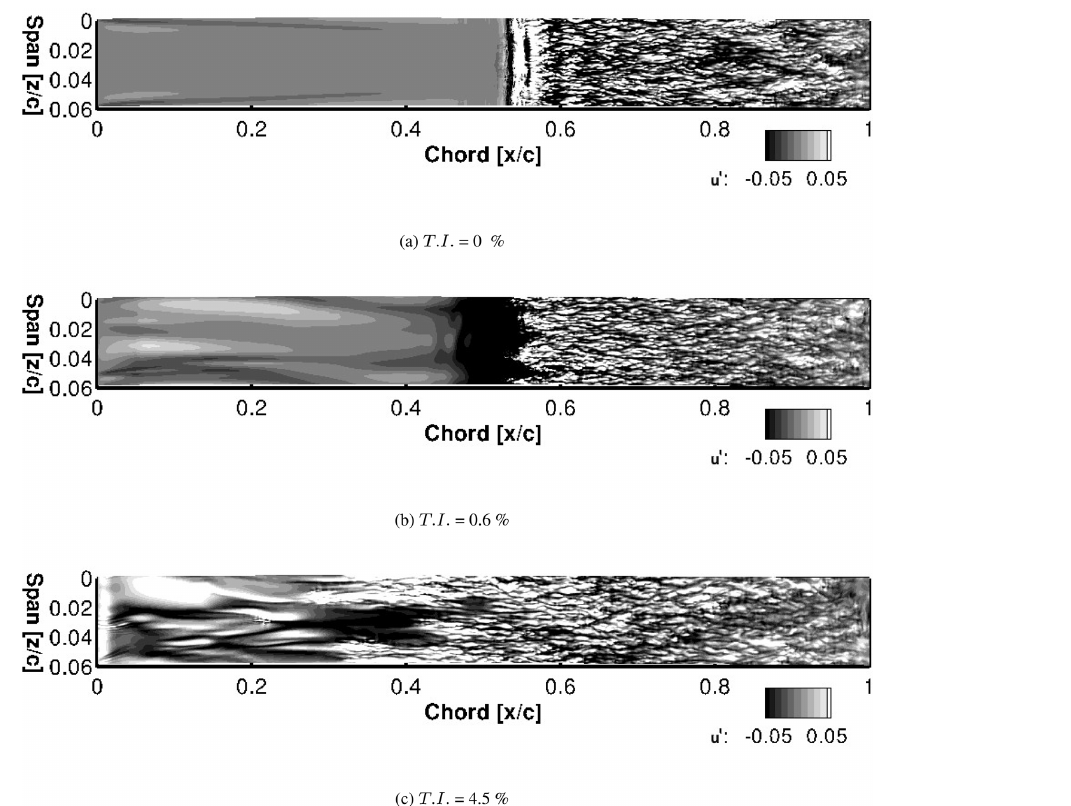
Figure 19. Snapshots of the instantaneous streamwise velocity disturbance u (cid:48) for the visualization of boundary layer streaks. Slices are taken at a wall-normal height corresponding to the displacement thickness at 0.5%